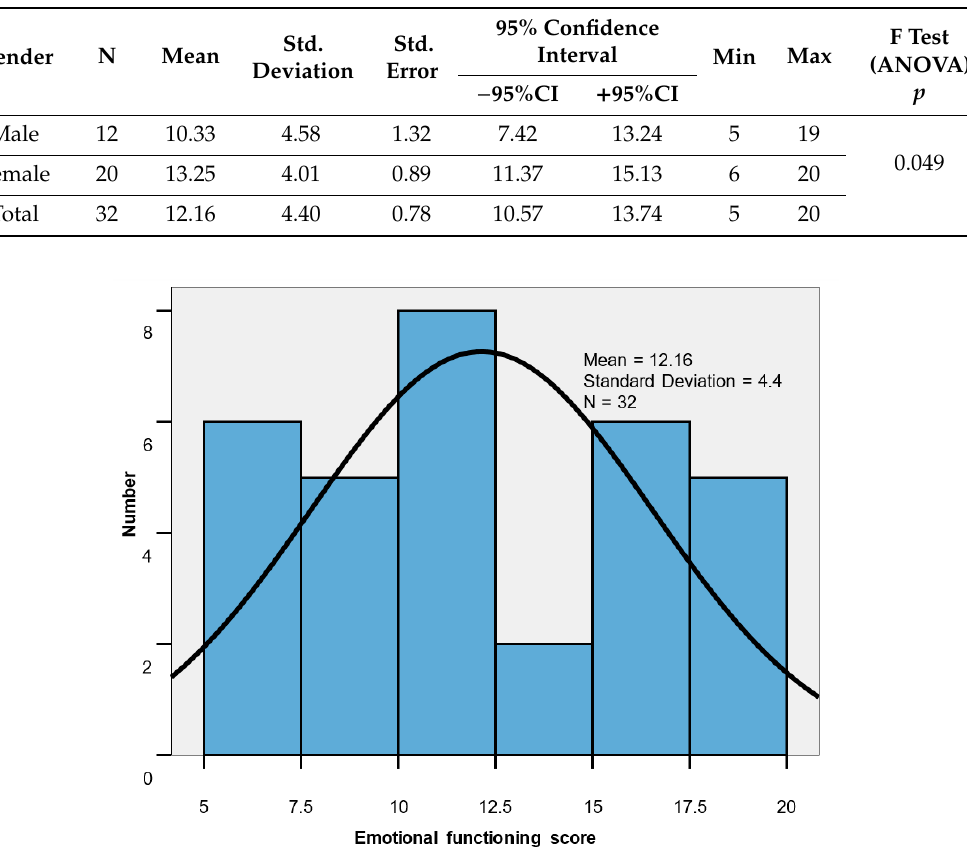
Figure 3. Emotional functioning score histogram